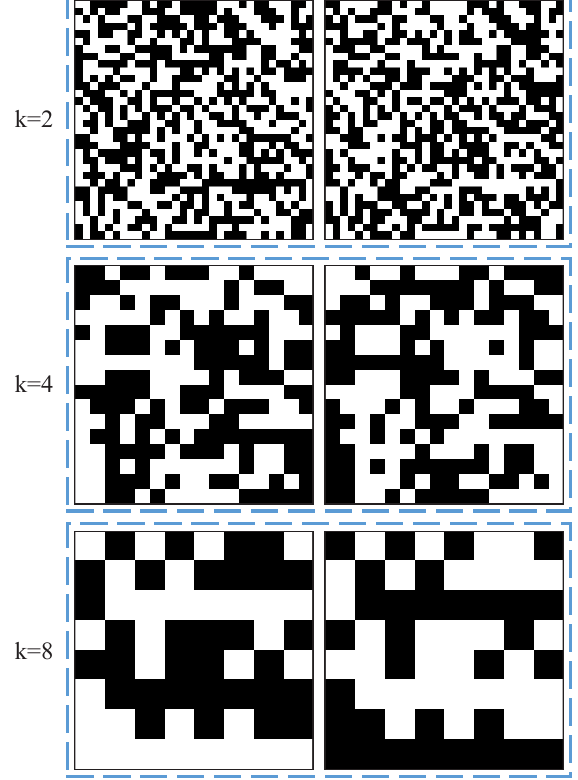
Figure 2. Visualization of the multi-scale grid